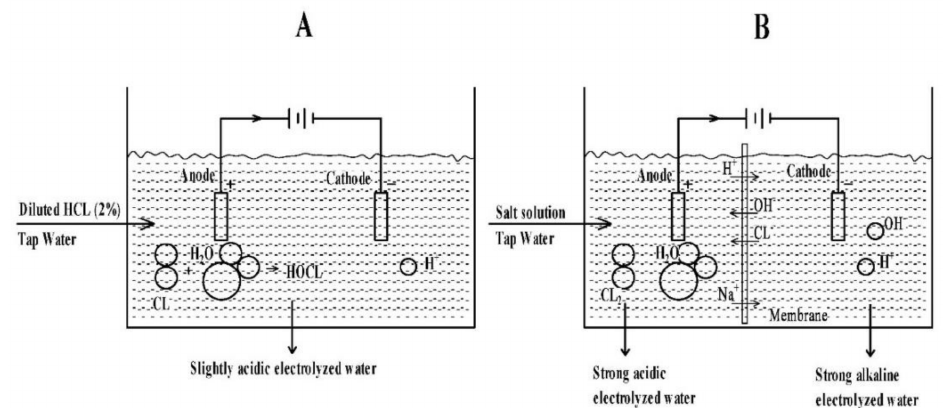
Figure 4. Schematic diagram of electrolyzed water production processes. ( A ) Slightly-acidic elec- trolyzed water, ( B ) acidic electrolyzed water, and essential electrolyzed water